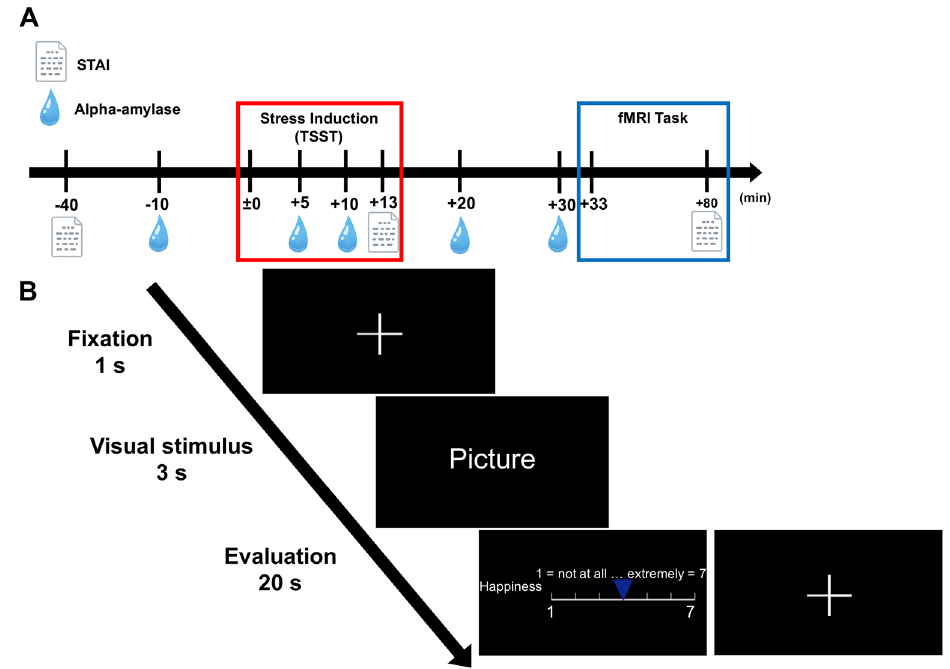
Figure 1. Experimental design and fMRI task. ( A ) Experimental procedure. Both stress and control conditions had the same schedule, but the content of the TSST differed between the two conditions. Onset (± 0 min) was set as the start of the stress test. ( B ) The emotion evaluation task in MRI. Participants underwent an emotion evaluation on a 7-point scale for photographic images displayed on the screen. Evaluations comprised